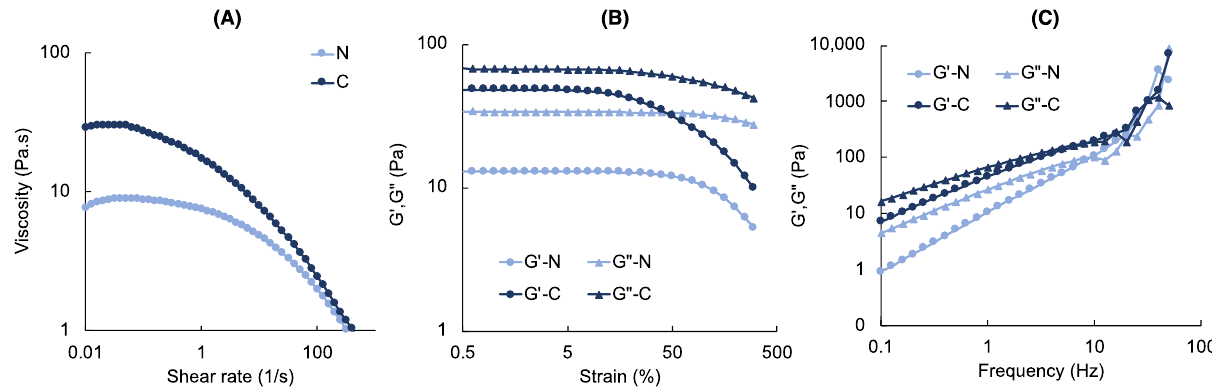
Figure 3. Rheology of the neat ( N ) and composite ( C ) inks. ( A ) Change in ink viscosity with shear rate. ( B – C ) Plots showing elastic ( G′ ) and viscous ( G″ ) modulus under ( B ) strain and ( C ) frequency sweep.